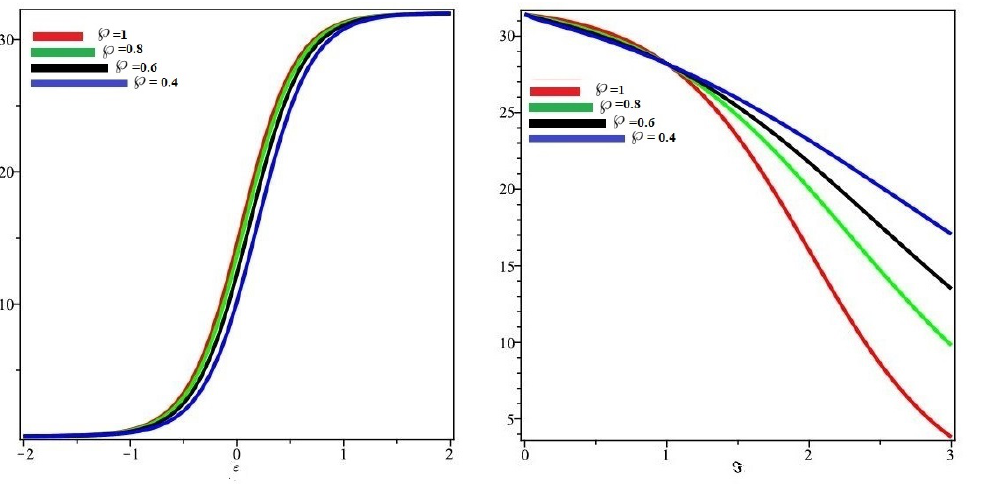
Figure 7. The fractional-order solutions of V ( ε , (cid:61) ) at ℘ of Example 2.